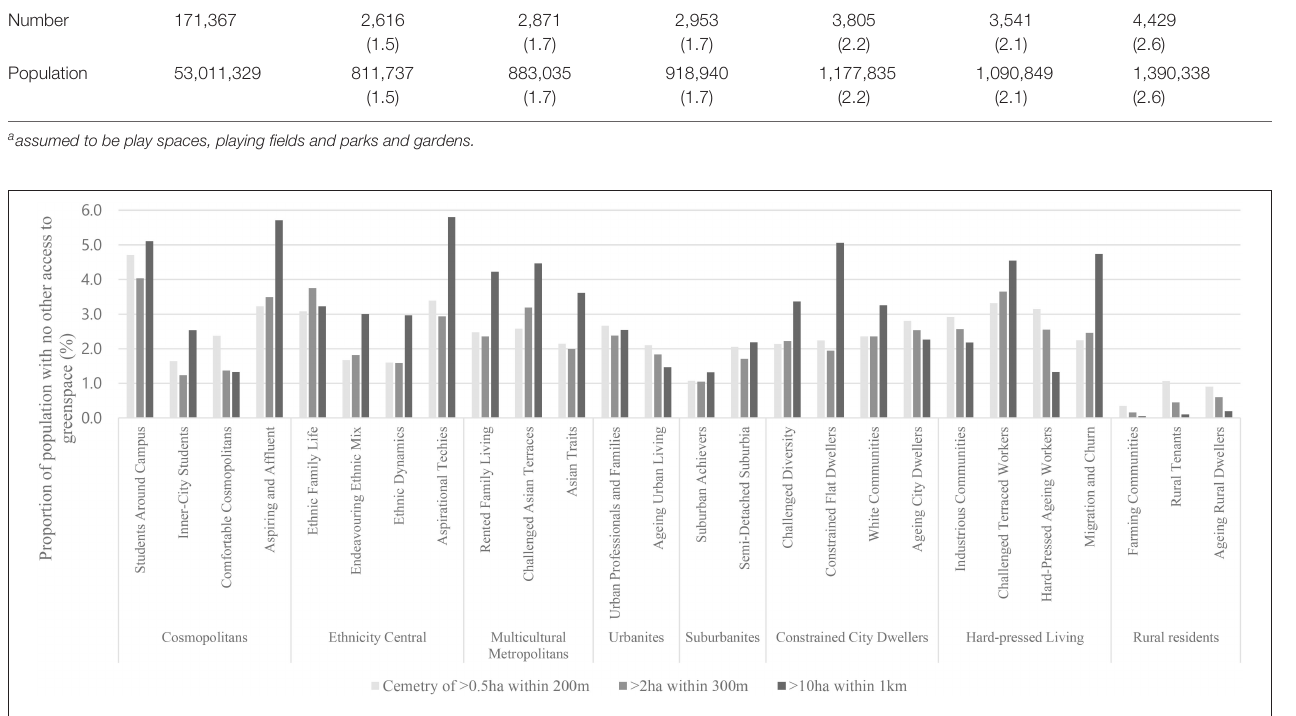
FIGURE 1 | Percentage of the population in social classification groups that live in output areas where the only greenspace meeting ANGSt is a cemetery based on the 2011 English